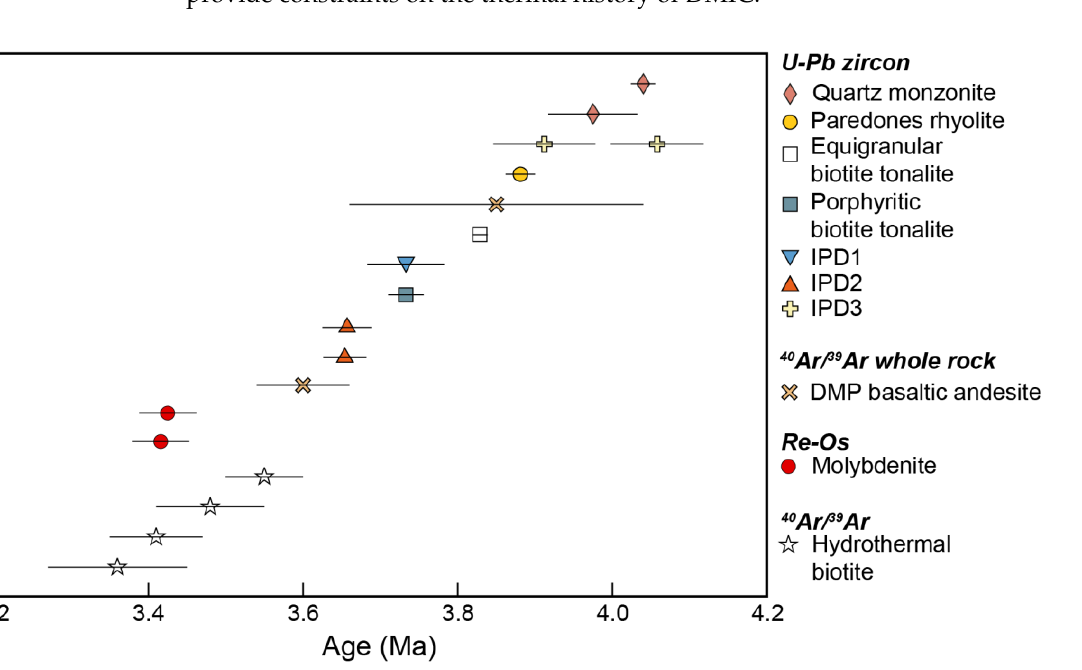
Figure 9. Summary of radiogenic ages for the igneous intrusions of the DMIC, mineralization, and hydrothermal alteration. U-Pb zircon ages and whole rock 40 Ar/ 39 Ar ages from Gilmer et al. [1] .